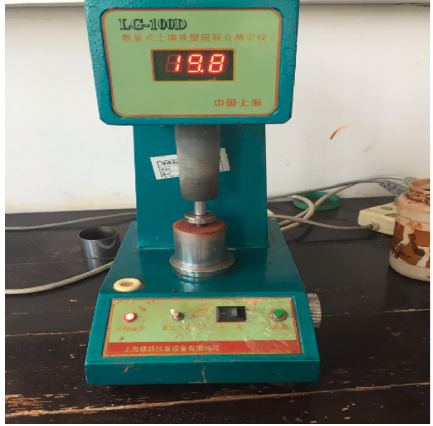
Figure 2: NDJ-8S rotary viscometer. Table 1: Experimental parameters and design of the soil